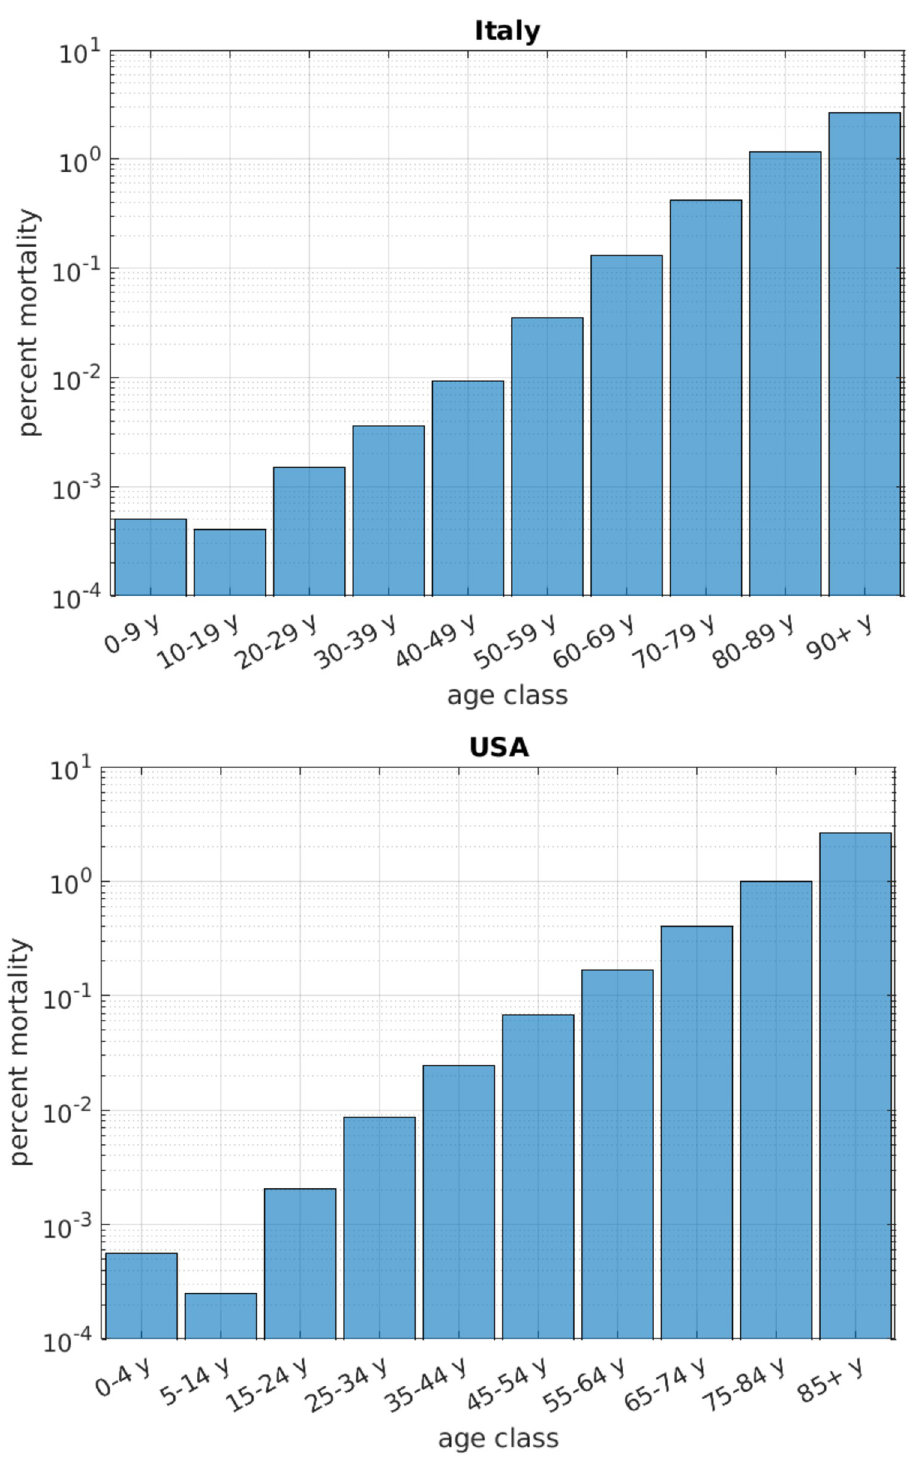
Fig 1. Mortality of the COVID-19 disease per age class. Italy data (top) based on COVID-19 data from [11]; US data (bottom) based on COVID-19 data from https://data.cdc.gov/NCHS/Provisional-COVID-19-Death-Counts-by-Sex- Age-and-S/9bhg-hcku, updated May 19, 2021, and on demographics data from https://www.statista.com/statistics/ 241488/population-of-the-us-by-sex-and-age.